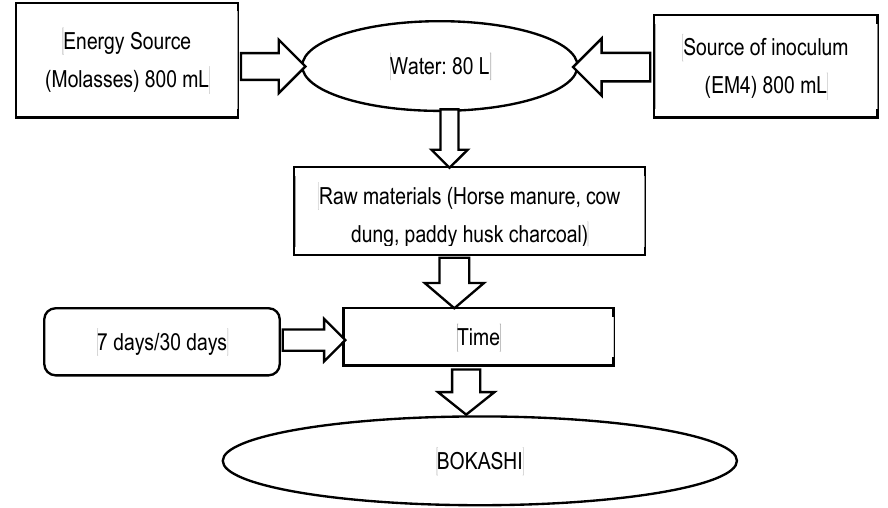
Figure 2. Summary of the bokashi fertilizer production process .